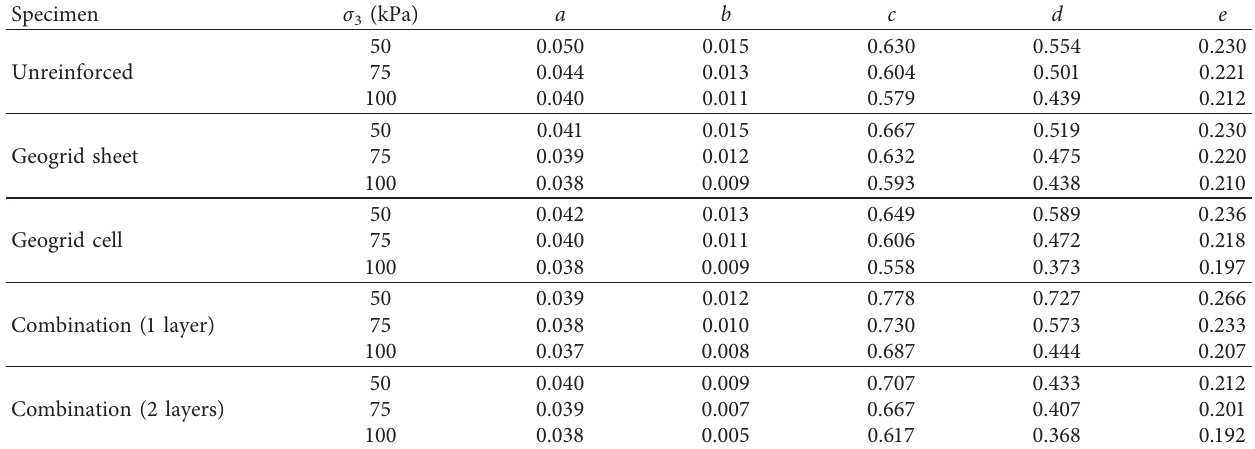
Table 3: Stress-strain and volumetric strain-axial strain model parameters of the test results.